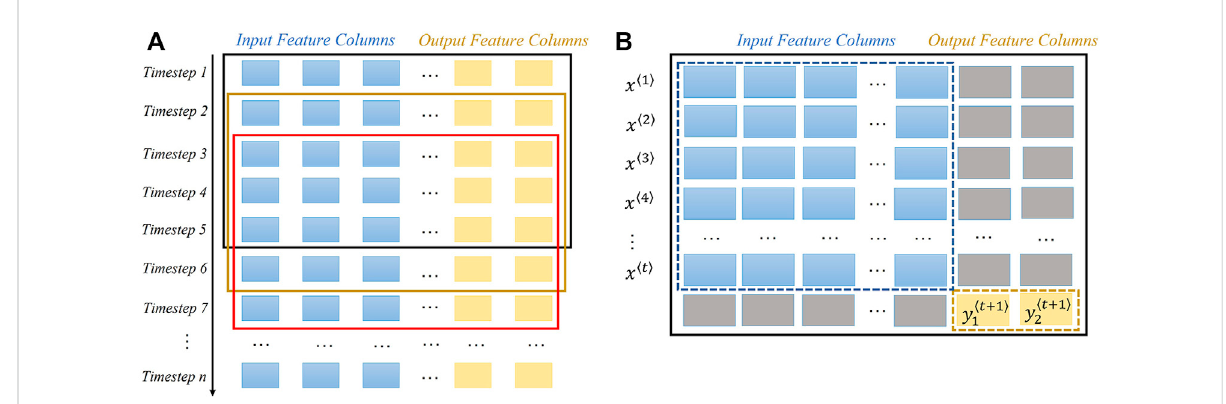
FIGURE 1 Slidingwindowillustrationfordatapointresample.Therearethirty inputfeaturesandtwooutputfeaturesintotal. (A) Showsthewindowsliding process in the sample matrix. Each row represents a timestep, each blue column means an input feature, and each yellow column indicates a target feature. (B) Demonstrates theprevious t timesteps are formed as one data point to predicttwo target variables in the nexttimestep. Blocks coloured grey are the abandoned